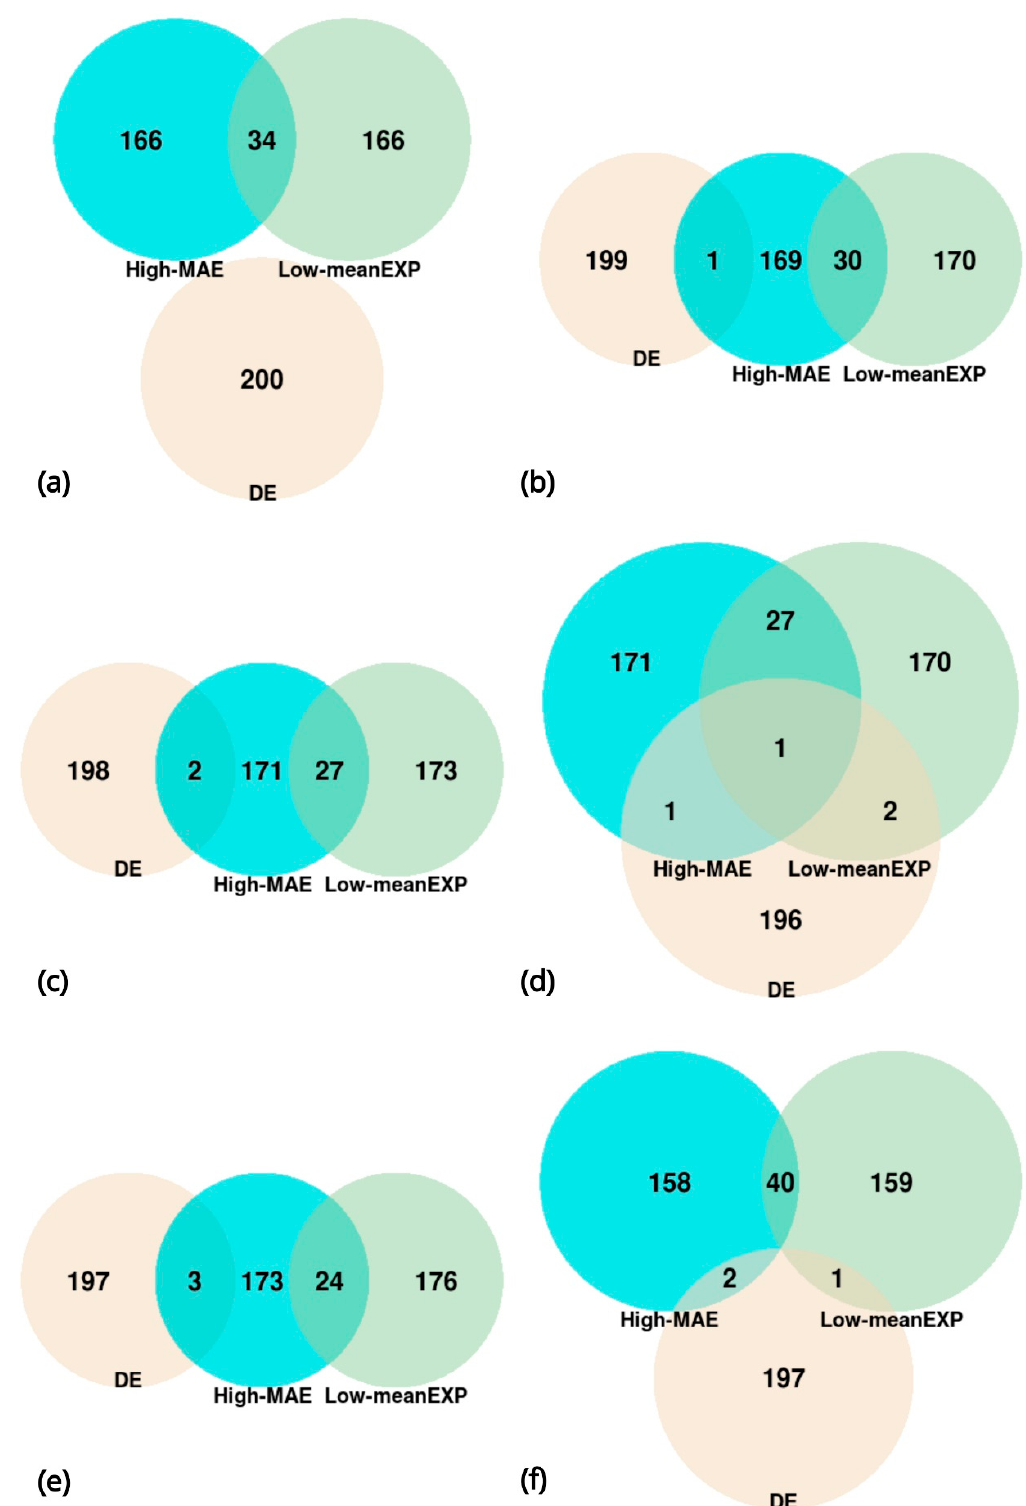
Figure 7. Overlap between the 200 high-MAE genes, the 200 low mean-expression (mean-EXP) genes, and 200 di ff erentially expressed (DE) genes of each cell type. ( a ) Human embryonic stem cells list (H1, n = 375 cells); ( b ) neural progenitor cells list (NPC, n = 173 cells); ( c ) definitive endoderm progenitors list (DEC, n = 138 cells); ( d ) trophoblasts list (TB, n = 69 cells); ( e ) endothelial cells list (EC, n = 105 cells), and human foreskin fibroblasts list (HFF, n = 159 cells).